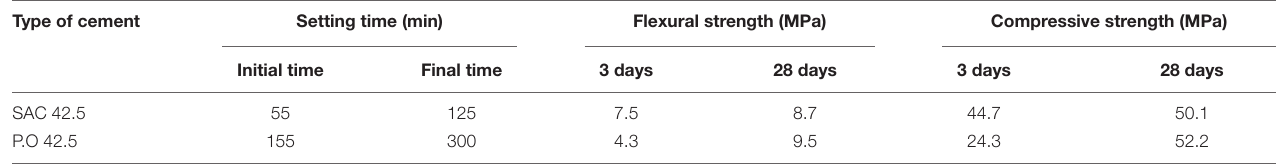
TABLE 2 | Properties of cement.